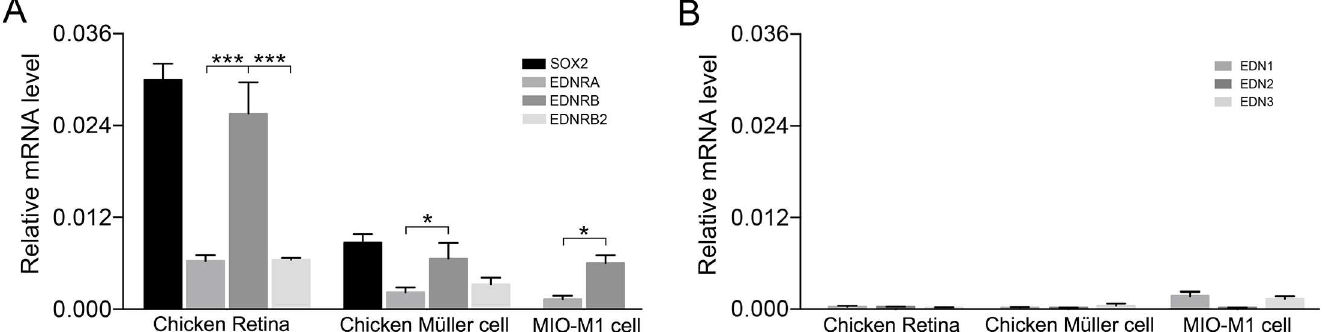
Fig 3. Relative mRNA levels of EDNs and EDNRs in E18 chicken retina, primary chicken Mu¨ller cells and the human MIO-M1 Mu¨ller cell line. qRT-PCR analysisof mRNA levels. Bar graphsshowingthe relative mRNA levels normalizedto ß-actin for (A) EDNRA, EDNRB, EDNRB2and SOX2, and for (B) EDN1, EDN2, EDN3 in chicken E18 retina (Chickenretina), primary chicken Mu¨ller cells (ChickenMu¨ller cell) and the humanMIO-M1 Mu¨ller cell line. Note that EDNRB2 is not found in human. For the MIO-M1 cells the relativemRNA levels of EDNRA and EDNRB are shown. Sox2 is includedas an expressionreference for the chicken cells. Bar graphs are mean ± SEM, n = 5 ( * P < 0.01, *** P < 0.0001) analyzedby one-wayANOVA and Tukey’s post hoc test. Significanceis only indicatedfor the comparisons: EDNRA-EDNRB, EDNRB-EDNRB2, EDN1-EDN2, and